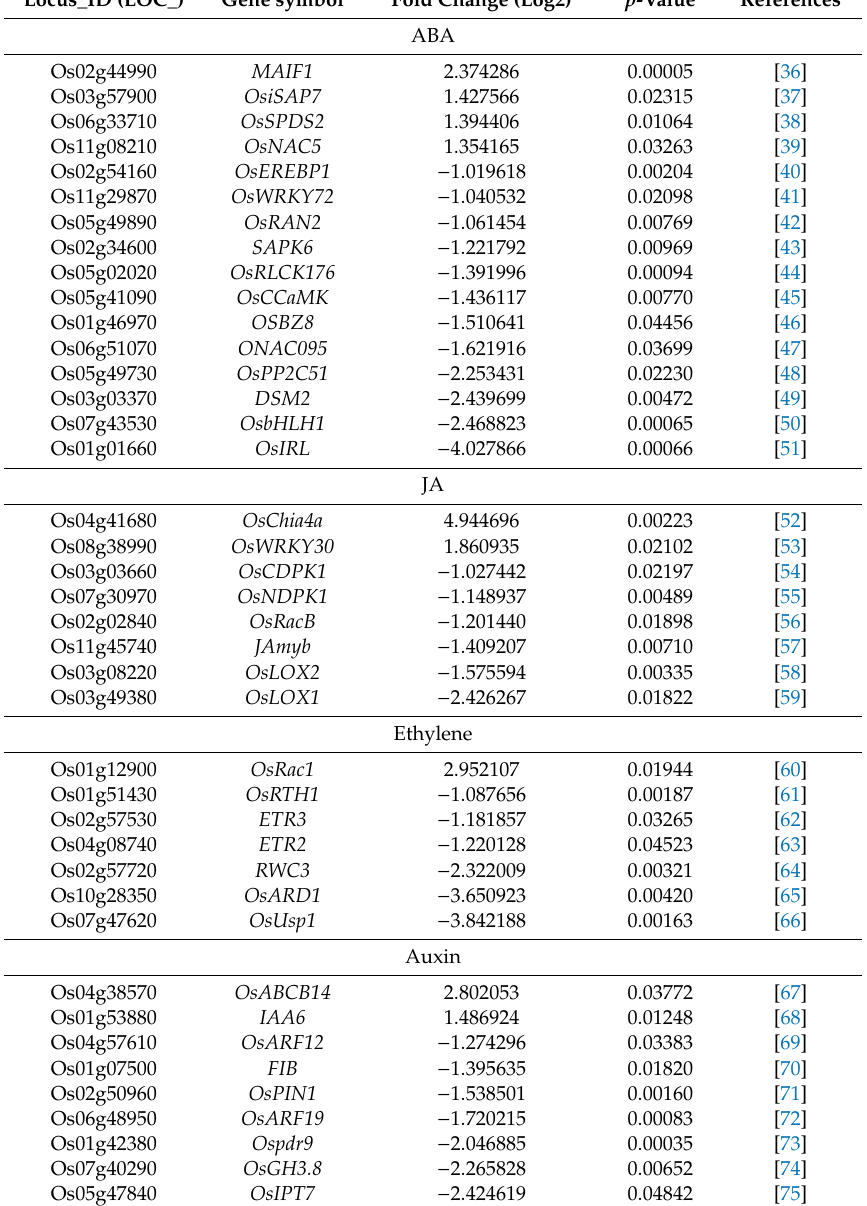
Table 1. Hormone-related genes di ff erentially expressed in ossrlk mutant by dark treatment.